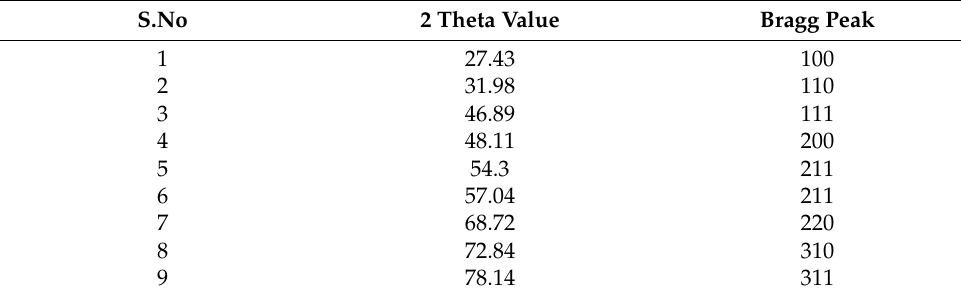
Table 2. Functional group that linked with the surface area of the P. alsinaefolia -Ag 2 ONPs . S.No.